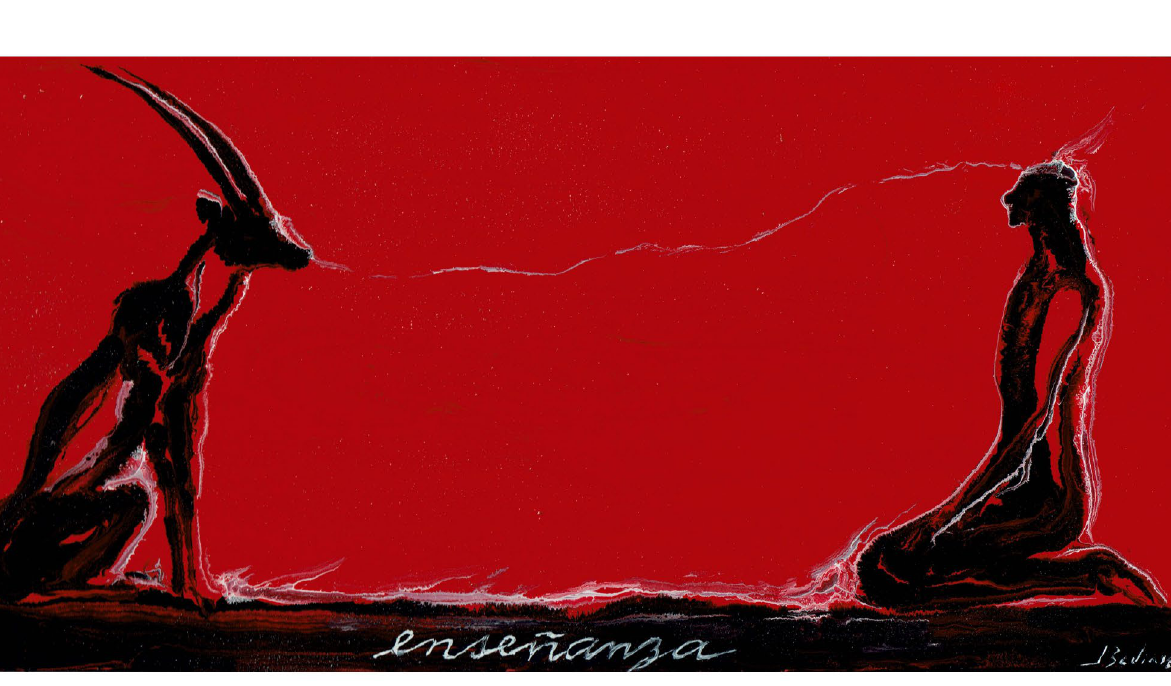
Figure 1. “Enseñanza” (“Teaching”). José Bedia, 2018, enamel on wood, 15 cm x 30 cm. Courtesy KGJ Collection,